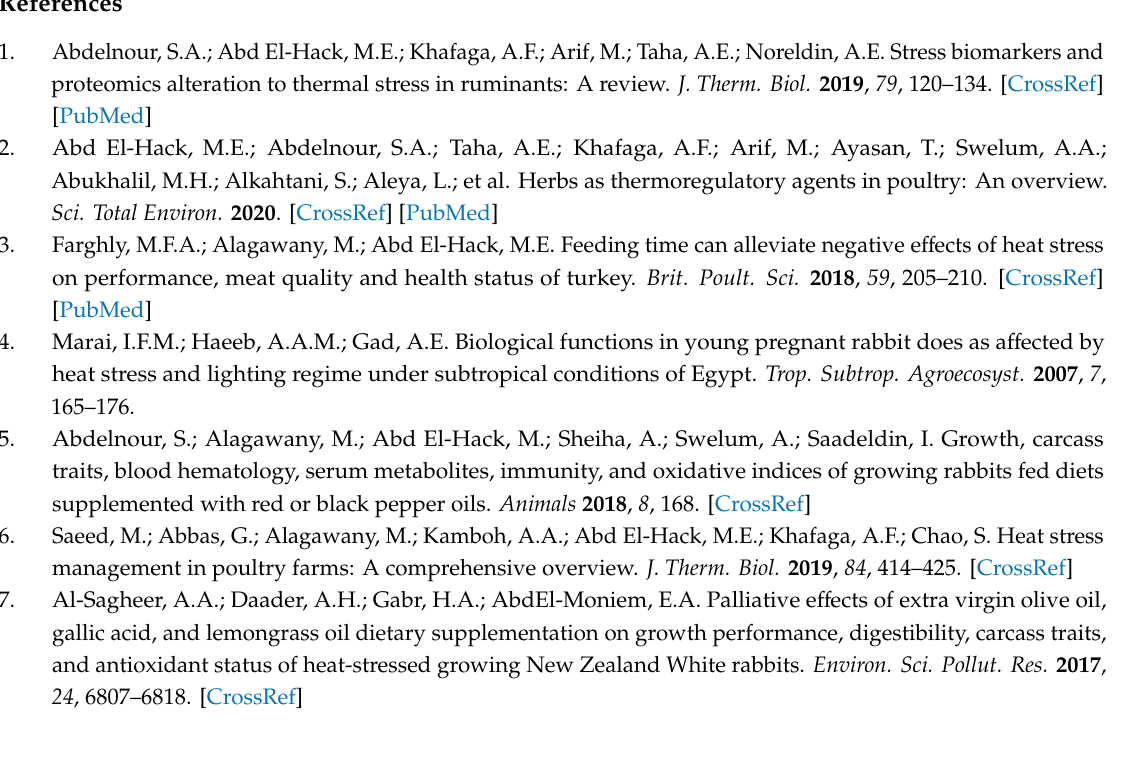
Table S1: Ingredients and composition of basal diet of growing rabbits (as